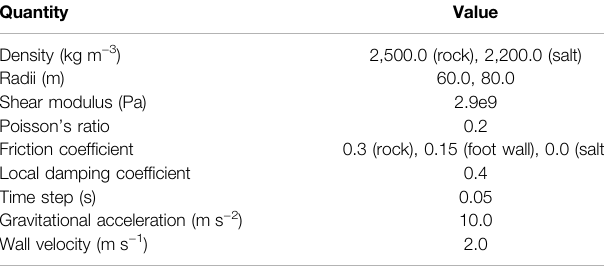
TABLE 1 | Particle properties and basic parameters for DEM simulation.